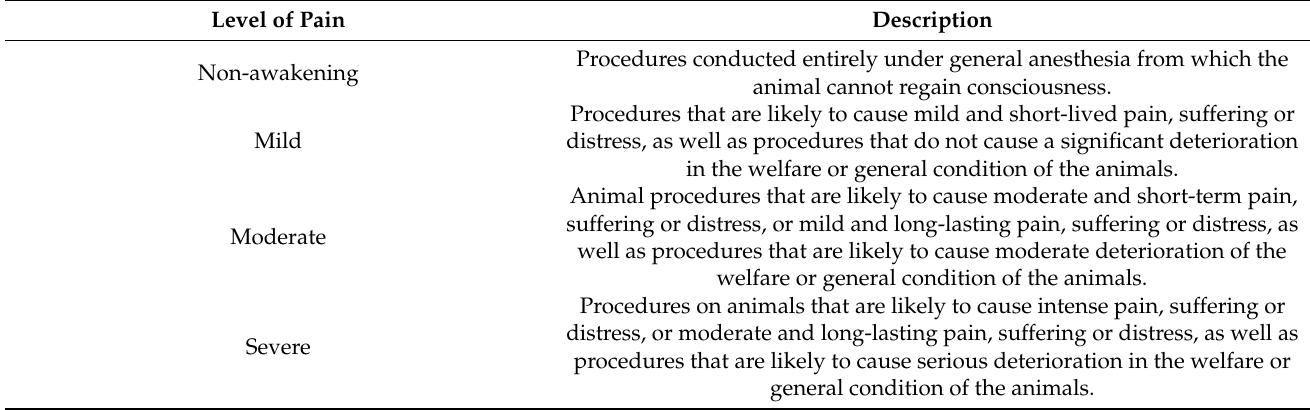
Table 2. Level of pain.